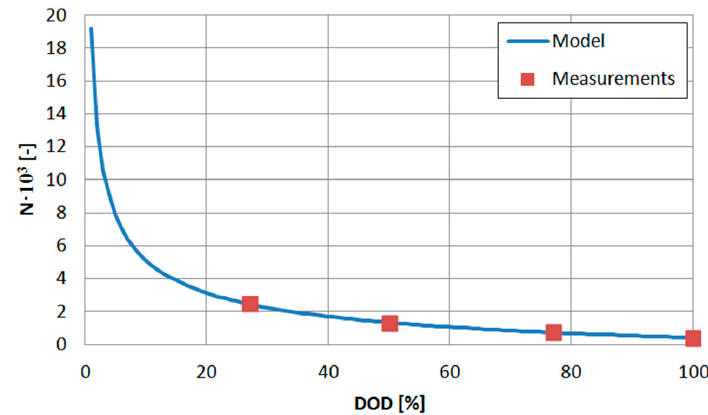
Figure 3. Impact of depth of discharge on cell cycle number. 194